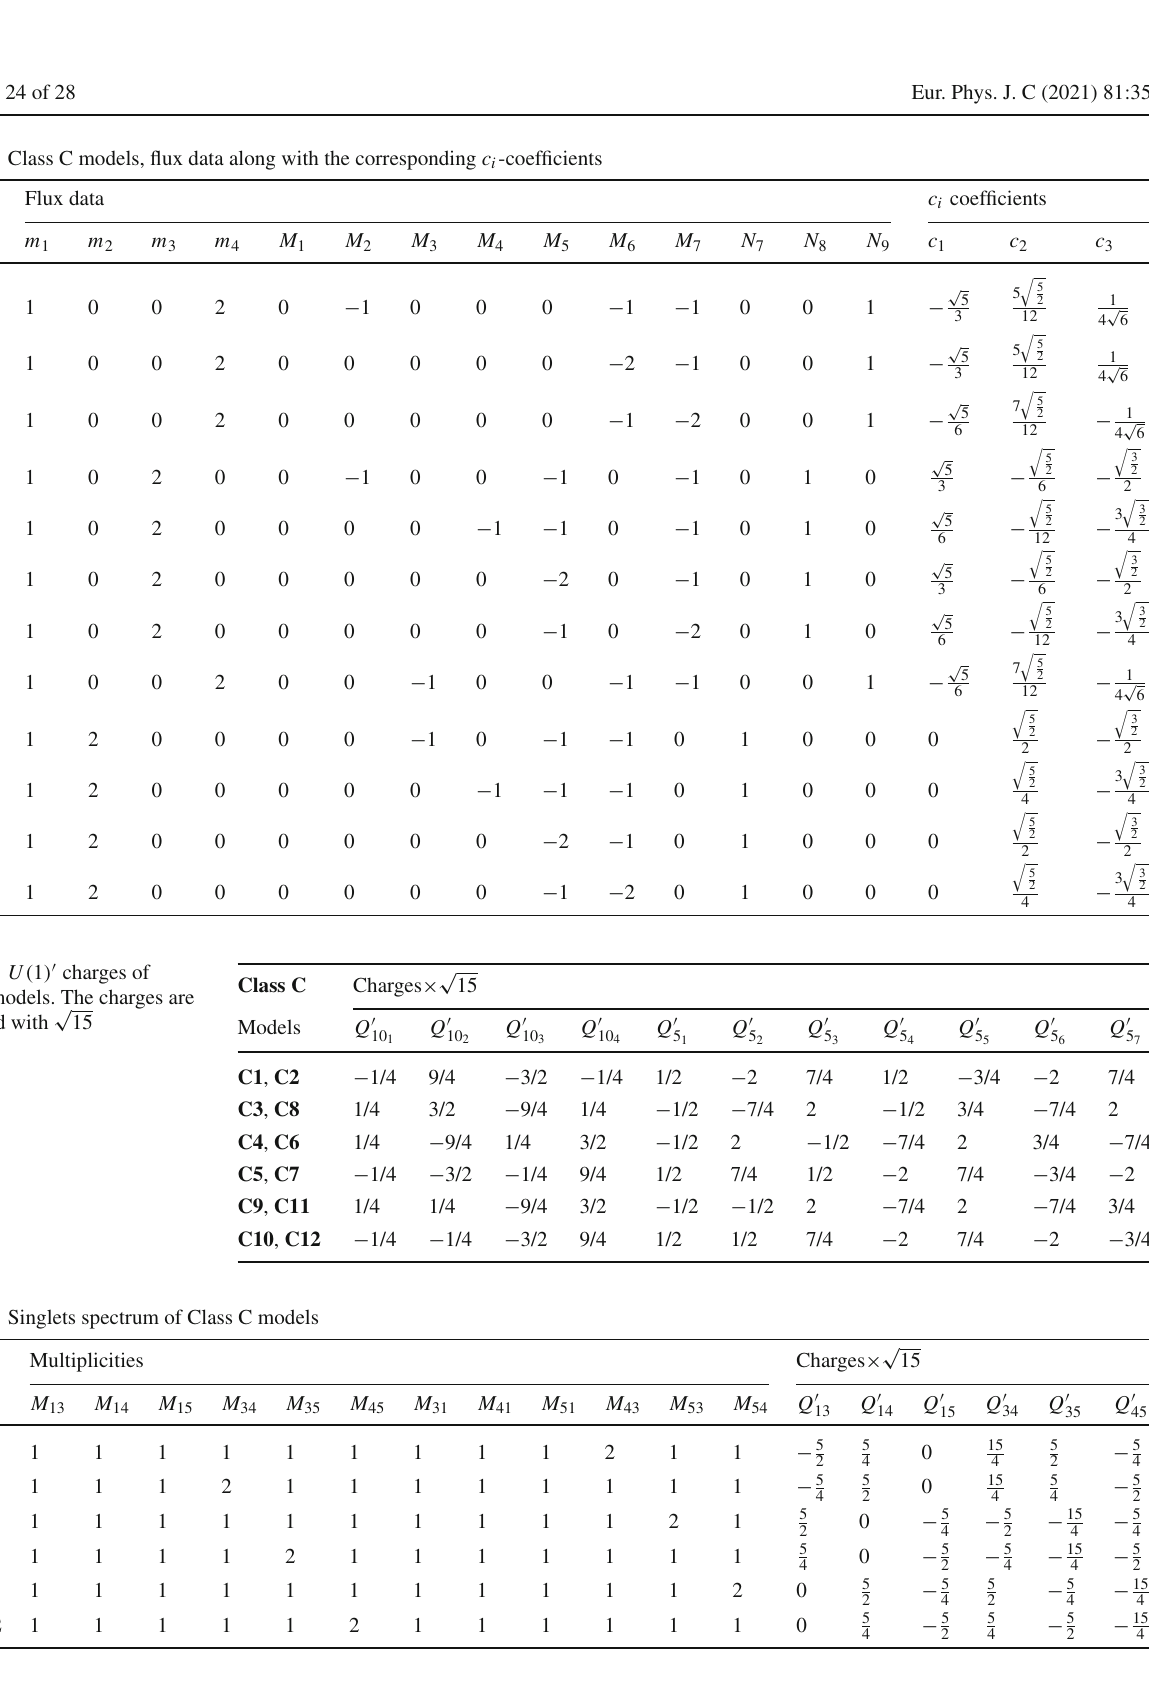
Table 13 Class C models, flux data along with the corresponding c i -coefficients